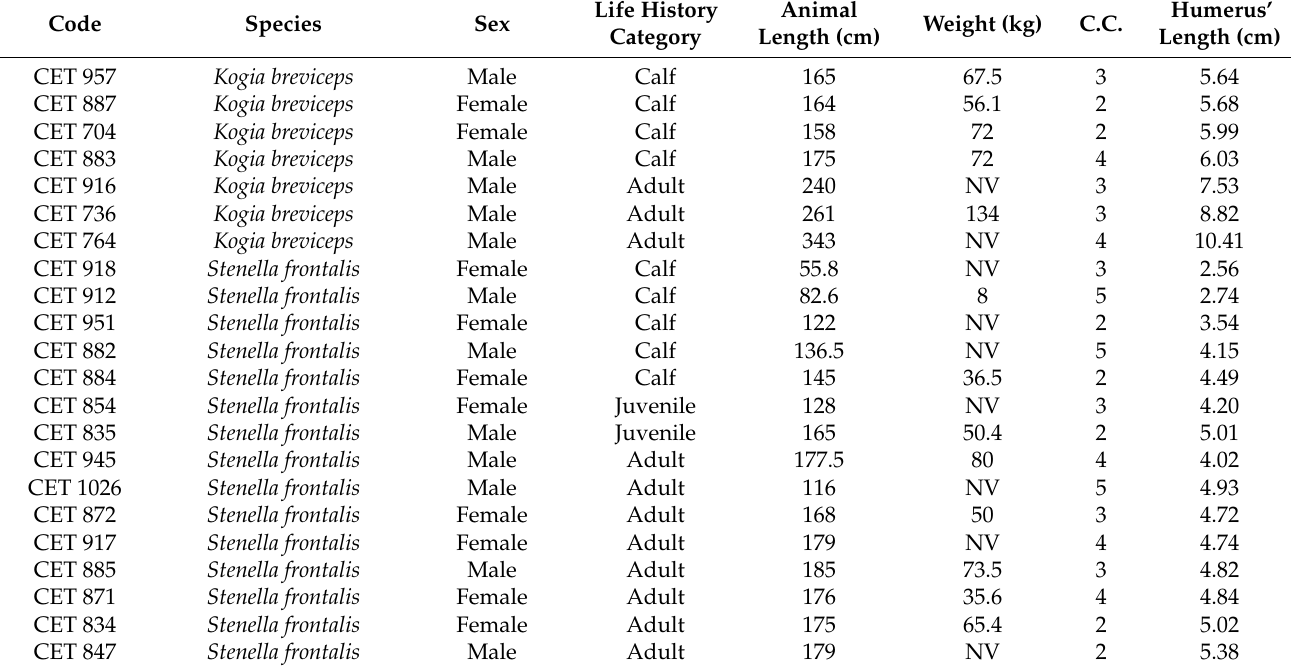
Table 1. Animals from which the flippers were dissected and analysed. NV: Not Valuable means these values could not be measured, because of logistic problems or because the animal corpse was in poor conservation condition. C.C.: Conservation